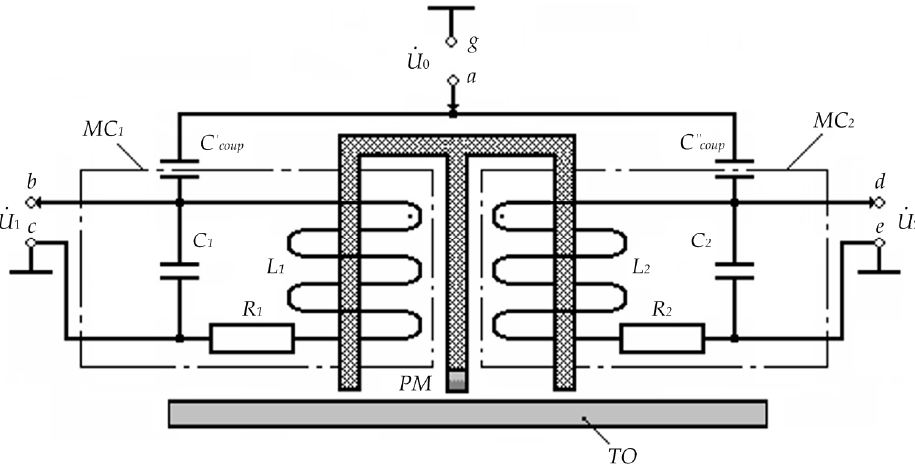
Figure 4. Circuit Diagram of the FS Substitution and Inclusion for the First Mode. . U 0 is the complex harmonic supply voltage of measuring coils; PM is the constant magnet inducing longitudinal magnetic fields in the core’s FC 1 and FC 2 elements with induction B 0 ; C 1 and C 2 are inter-turn capacitances of, respectively, MC 1 and MC 2 windings; R 1 and R 2 are active resistances of, respectively, MC 1 and MC 2 windings; L 1 and L 2 are inductances of, respectively, MC 1 and MC 2 windings; C (cid:48) capacitors of, respectively, MC 1 and MC 2 windings, which are, structurally, capacitors with parasitic capacitances formed by a copper cylindrical electrode with coaxially located core elements and the first lower rows of, respectively, MC 1 and MC 2 windings. . U 0 ) is applied to MC 1 and MC 2 windings through, respectively, C (cid:48) magnitude— which are also electrical parameters of MC 1 and MC 2 , and output signals read from respective input ends of MC 1 and MC 2